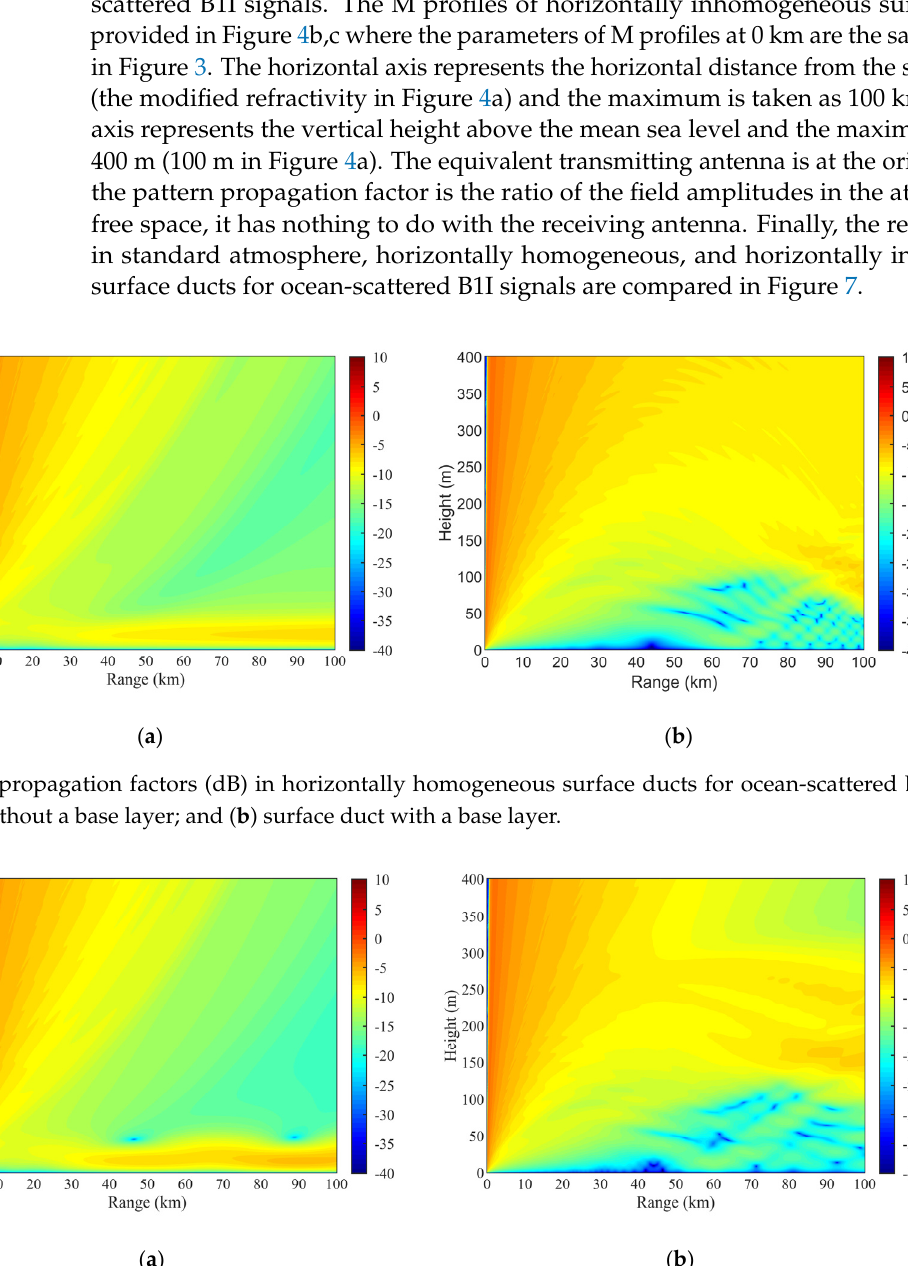
Figure 6. Pattern propagation factors (dB) in horizontally inhomogeneous surface ducts for ocean-scattered B1I signals: ( a ) surface duct without a base layer; and ( b ) surface duct with a base layer.